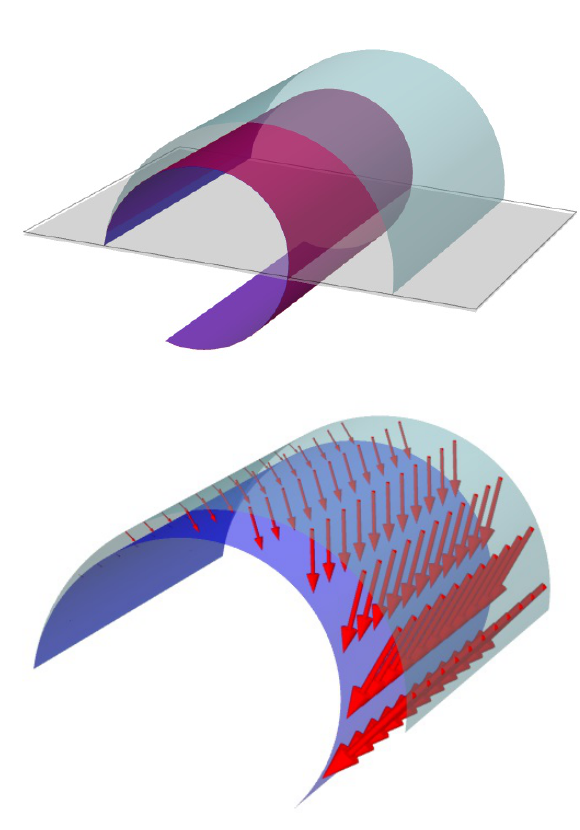
Figure A1: Top. Computational domain Ω (gray), reference surface ^ f ^ f ( Ω ) (red). Bottom. Displacement ¯ y ( Ω ) (cyan) and actual surface y field u = ^ f − ^ f ¯ (red arrows), represented as a spatial field u = y y u (^ f ¯ y ( Ω ))